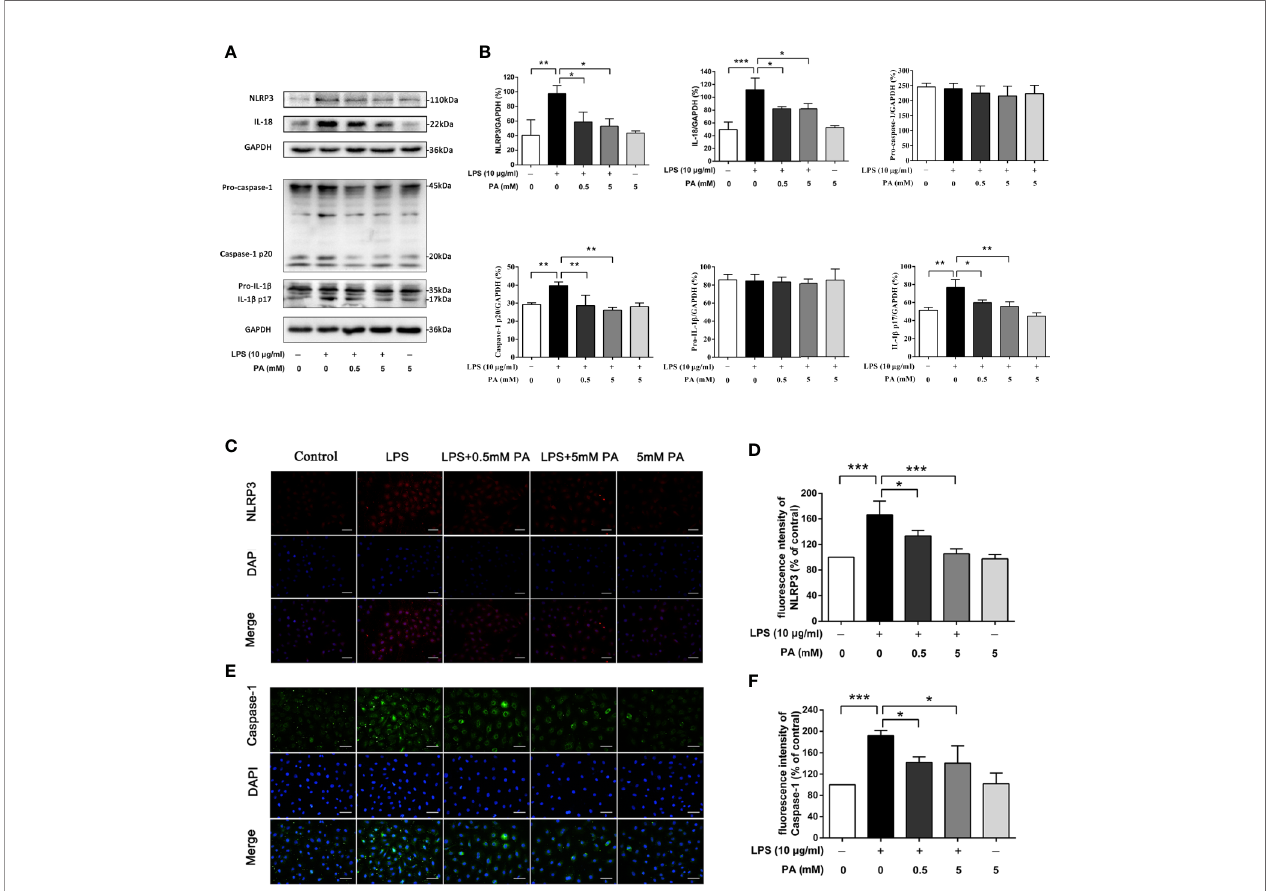
FIGURE 4 | The effects of PA on the activation of NLRP3 in fl ammasome in LPS-treated IEC-6 cells. (A) The expressions of NLRP3, pro-caspase-1, caspase-1, pro- IL-1 b , IL-1 b , and IL-18 at protein levels were determined by western blot analysis and were quanti fi ed in (B) . (C) NLRP3 and (E) caspase-1 were detected by immuno fl uorescence combined with DAPI staining for nuclei (scale bar: 30 m m). The fl uorescence intensities of (D) NLRP3 and (F) caspase-1 were determined using Image J software. The data represent the averages ± S.D. Signi fi cant differences between the treatment and control groups are indicated as *P < 0.05, **P < 0.01, ***P < 0.001. Signi fi cance was determined by one-way